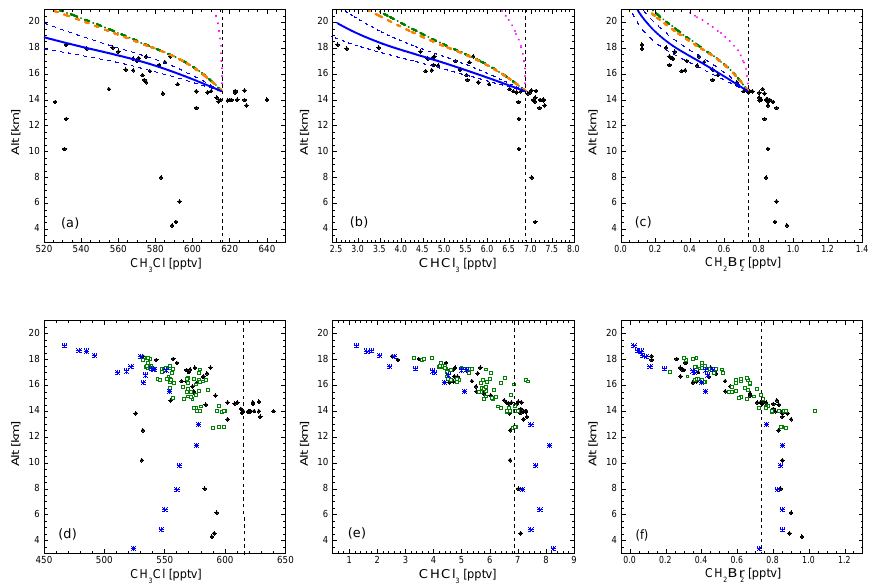
Fig. 5. Vertical distributions of (a) CH 3 Cl, (b) CHCl 3 , and (c) CH 2 Br 2 . Shown are the simulated profiles of 1-D model using combined inputs of photolysis and reaction with OH radicals. Dash-dotted green lines represent the base case using the OH estimate derived from the GMI model. The dashed orange lines denote the resulting simulation with the GMI-derived OH estimate, and the w and K values determined from the hypothetical profile (orange line in Fig. 3c). An adjusted OH profile with a scaling term of 2nd polynomial function from the base OH give the best fits to the all three observations. The simulation results using the optimal OH concentration profile are shown in blue solid lines. The blue dashed lines around the solid one correspond to uncertainties in the simulation that ± 30% uncertainties in [OH] (blue dotted lines in Fig. 6) can produce. Photolysis-only runs are plotted as pink dotted lines. Vertical profiles of (d) CH 3 Cl, (e) CHCl 3 , and (f) CH 2 Br 2 in the TTL ( < 11 ◦ N) are compared with observations both from 11–25 ◦ N (green empty squares) and from 25–36 ◦ N (blue asterisks) on 3 and 9 August, without showing any significant separation from the extratropical